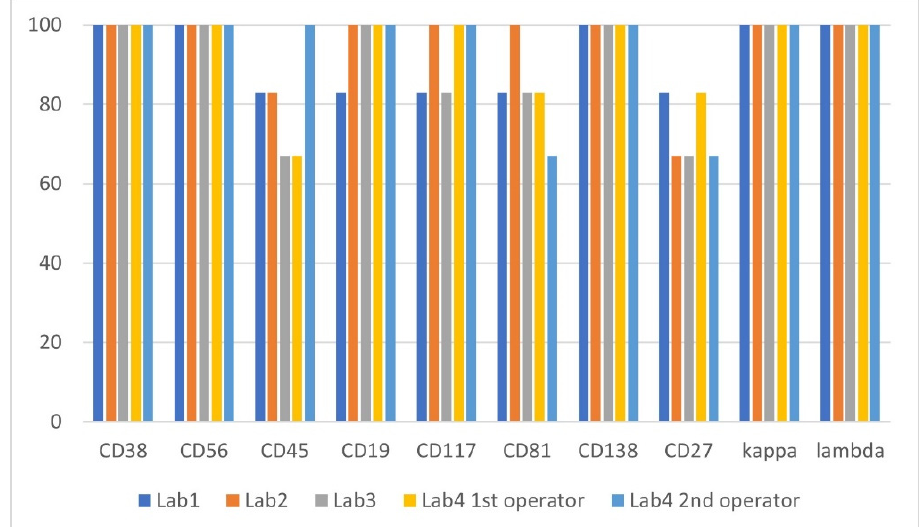
Figure 4. Concordance of antigen expression determination (in percentages) achieved for 6 study cases consistently identified as MRD-positive by 5 operators.